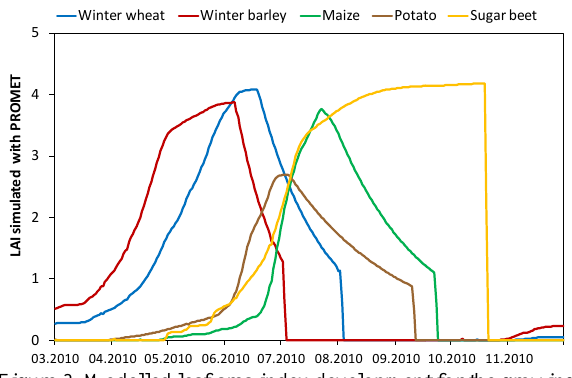
Figure 3. Modelled leaf area index development for the growing season of 2010 for the crop types in the test site, corresponding to scenarios with optimal plant development.